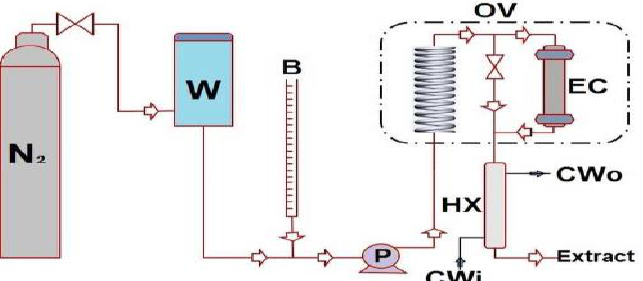
Figure 4 . The supercritical water extraction system diagram: OV: furnace; HX: heat exchanger; EC extraction chamber; W: water storage; CWi: cooling water; CWo cooling the water; B: